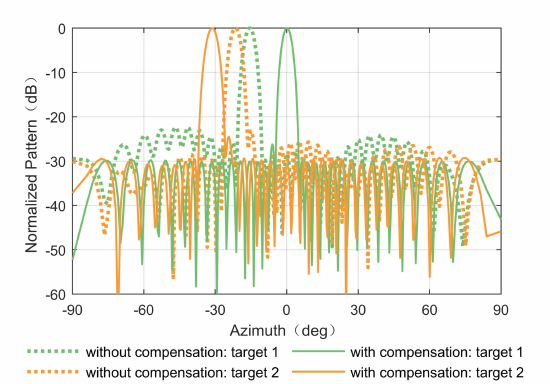
Figure 6. Direction-of-arrival (DoA) estimation results.